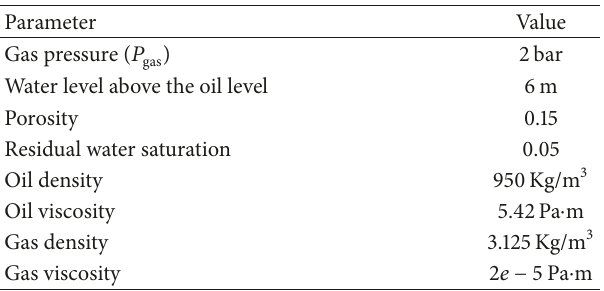
Table 2: Corresponding parameters of the oil and gas seepage modelling